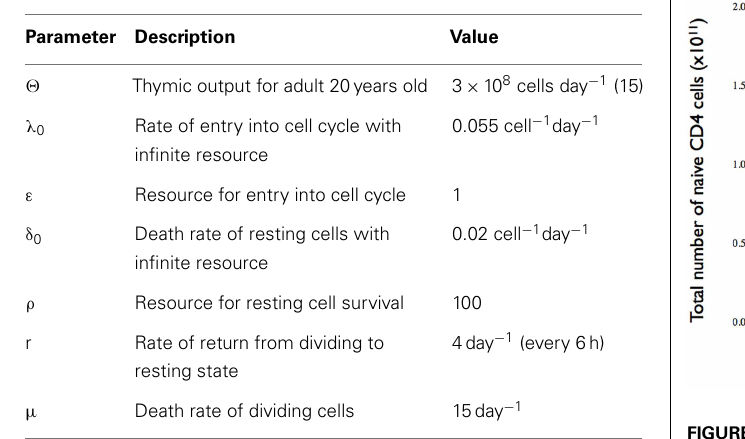
Table 1 | Parameter values used for the model .